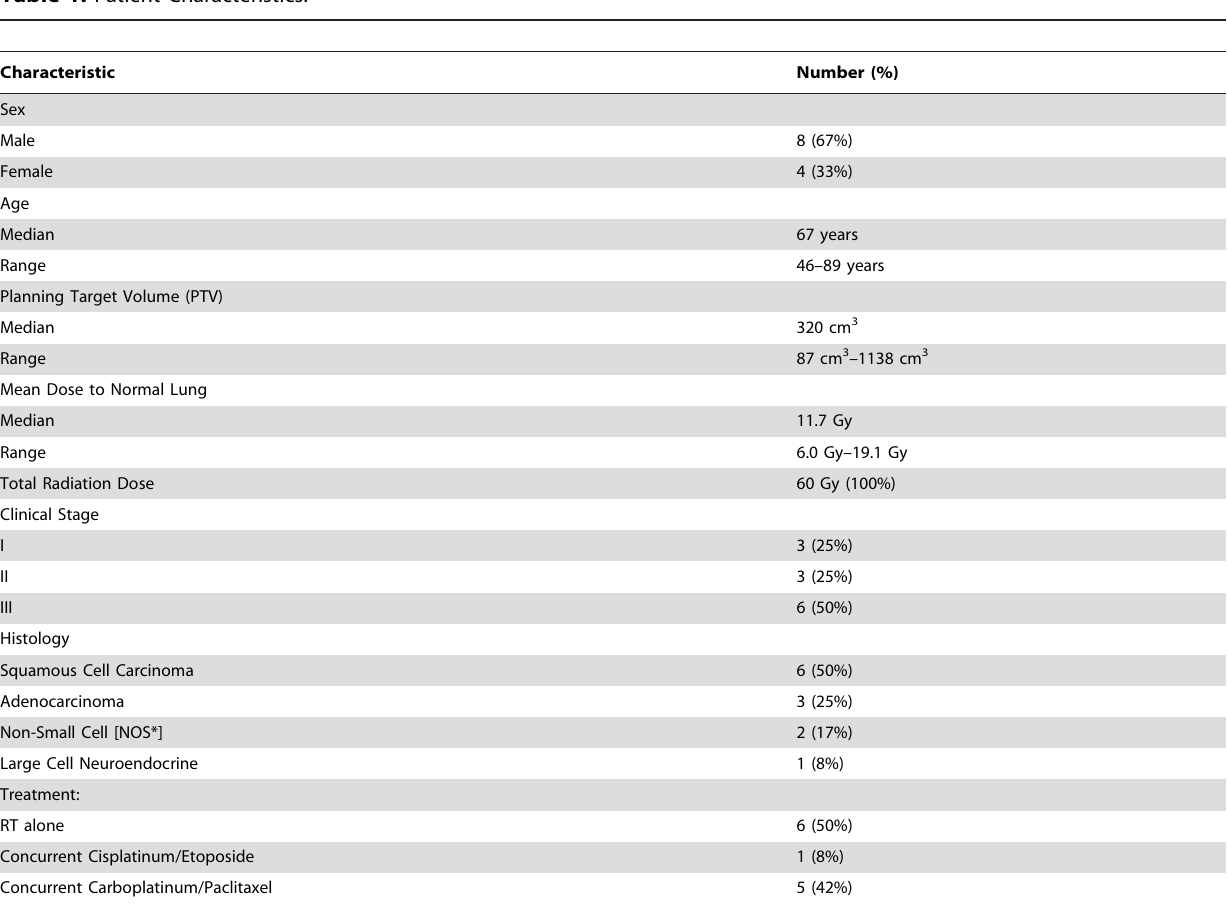
Table 1. Patient